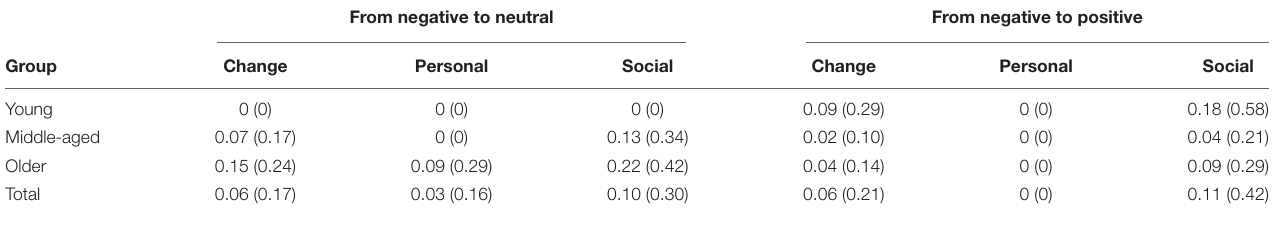
TABLE 3 | Mean proportion (SD) of valence changes from initially negative to neutral or positive statements, for personal and social claims in young, middle-aged, and older adults. From negative to neutral From negative to positive Group Change Personal Social